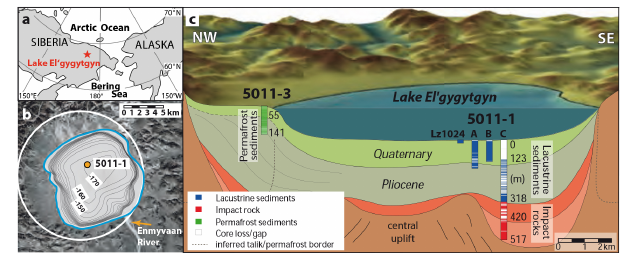
Figure 1. (a) Map showing the location of Lake El’gygytgyn in the western Beringian Arctic, (b) Aerial image of the El’gygytgyn im- pact crater, bathymetry of Lake El’gygytgyn, and location of ICDP drill site 5011-1. The white circle shows the dimensions of the crater rim, (c) Schematic cross-section of the El’gygytgyn basin stratigra- phy with location and recovery of ICDP sites 5011-1 and 5011-3 (modified after Melles et al., 2011). At site 5011-1, three holes (1A, 1B, and 1C) were drilled to replicate the Pleistocene and upper- most Pliocene sections. Lz1024 is a 16m long percussion piston core taken in 2003 that fills the stratigraphic gap between the lake sediment surface and the top of drill cores 1A and